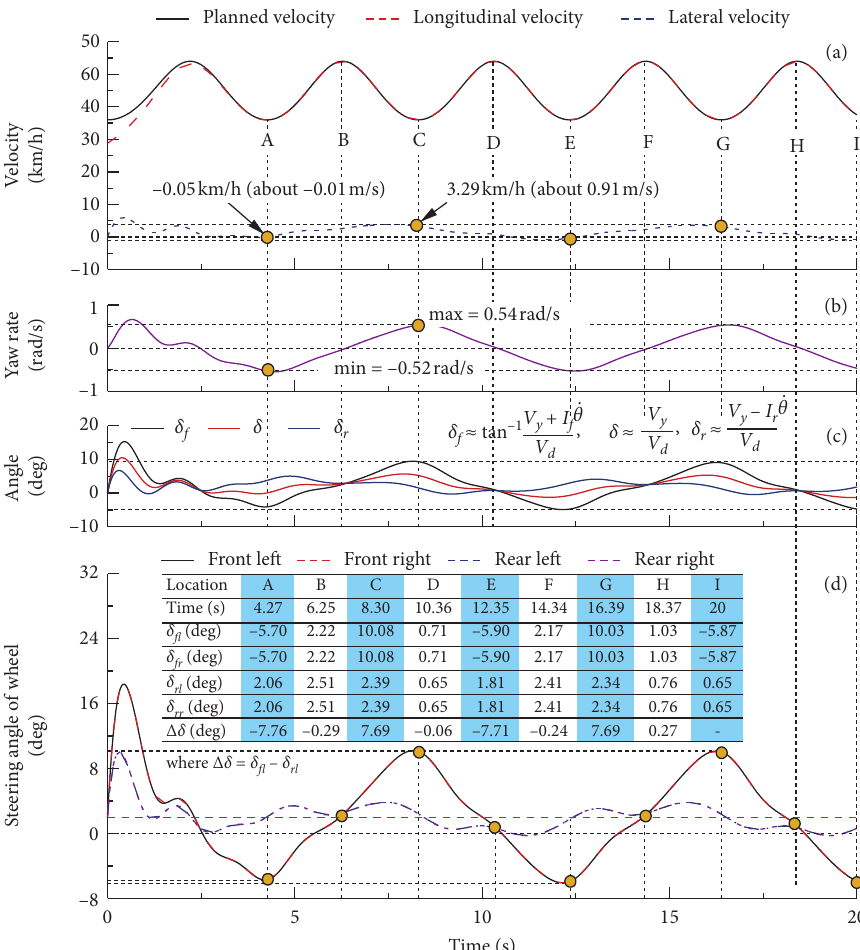
Figure 17: Time histories for several variables of the vehicle in sinusoidal path-following motion.